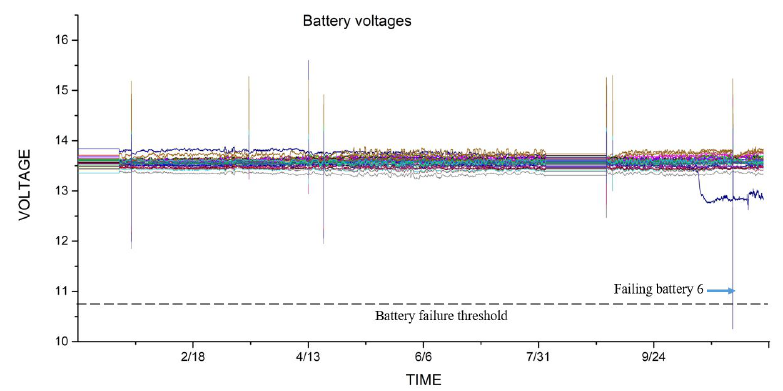
Figure 4. One year battery voltages in data center.